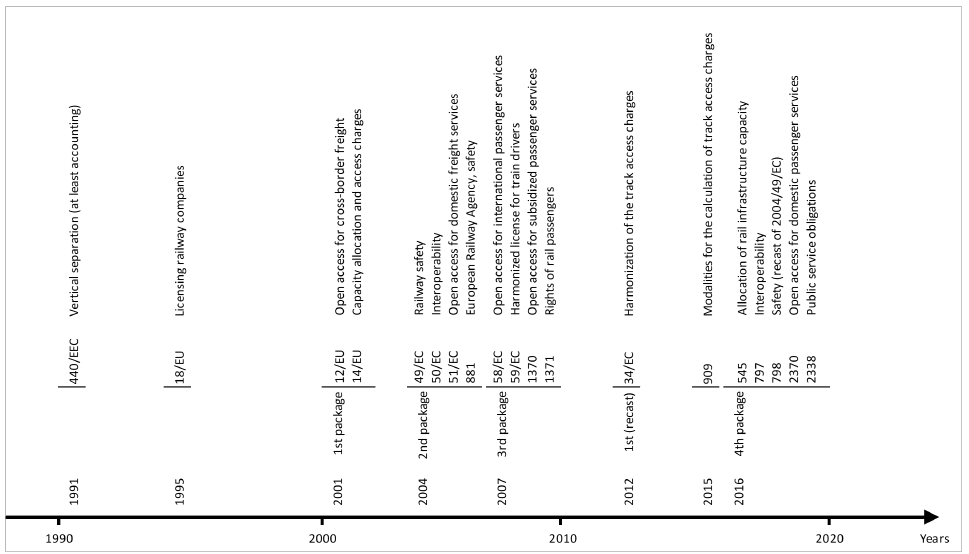
Figure 5. European legal acts on the deregulation of the railway market. Own study based on [68,69]. By way of comparison, it should be added that the model of railway market deregula- tion adopted for restructuring in the U.S. does not include the vertical separation, which is the basic principle of European deregulation. The American model is based on geo- graphical separation, separating individual segments of the railway network in such a way that they are operated essentially by one operator. This model assumes that a particular network is operated by a single operator and that competition occurs between alternative networks offering connections between different regions of the country [70]. This choice was influenced by several factors that differentiate the American rail system from the European one. The lower network density, dominant private ownership of